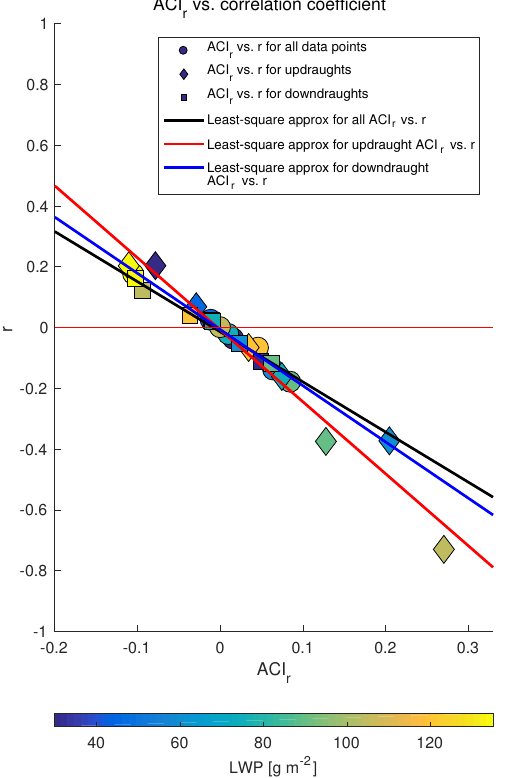
Figure 6. Scatter plot between ACI r and the Pearson product– moment correlation coefficient, r